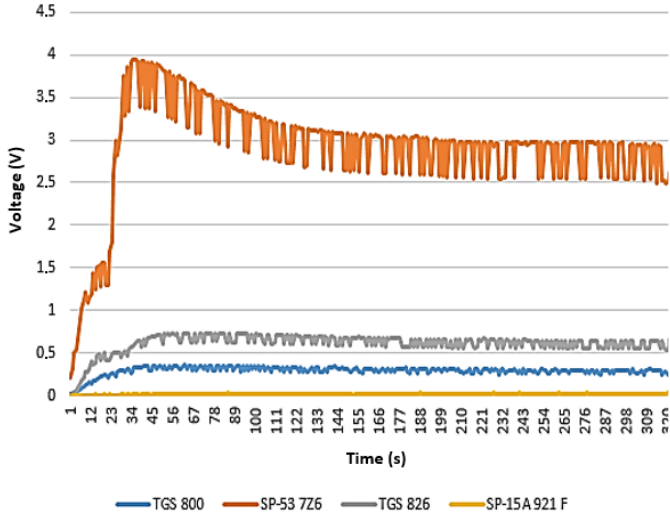
Figure 11. Response of the sensors subjected to temperature modulation with a sample of. Moscatel wine; alcohol